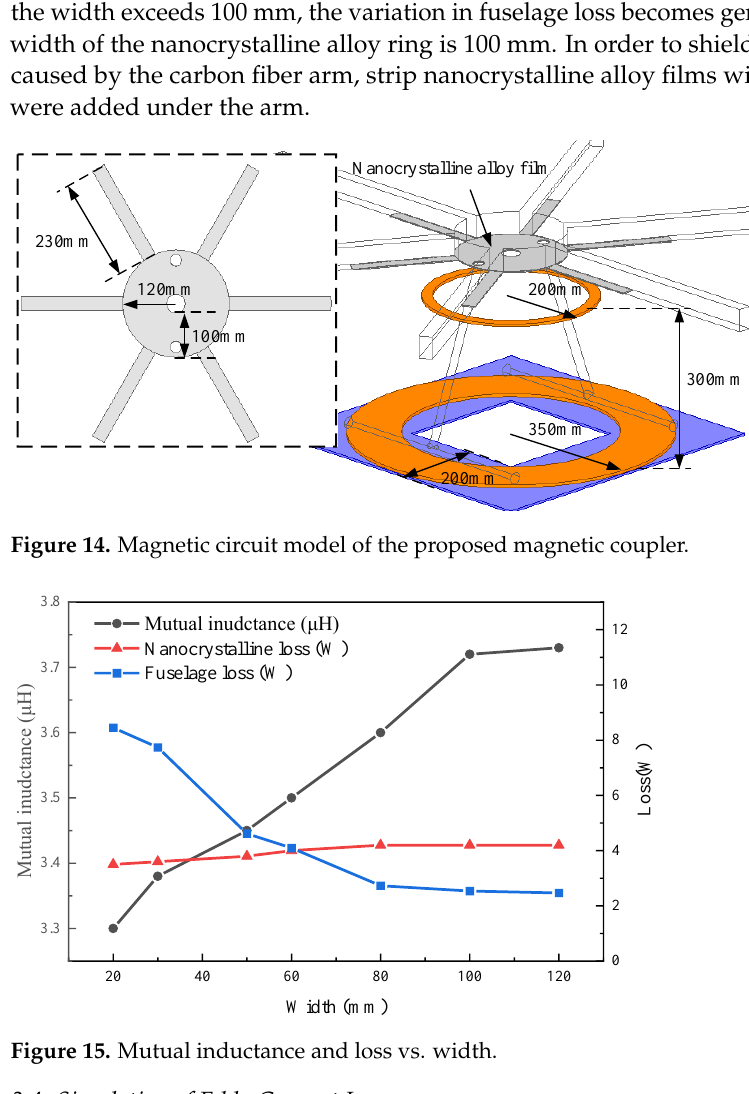
( b ) Figure 16. Eddy current loss distribution. ( a ) Without nanocrystalline and ( b ) with nanocrystalline.